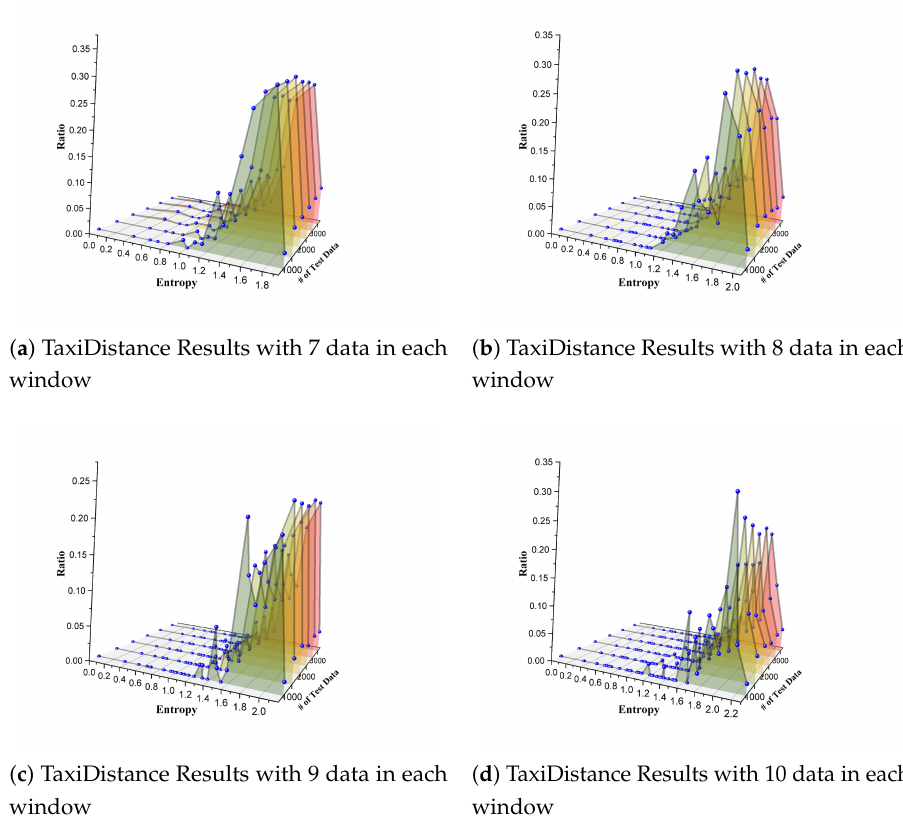
Figure 10. The distribution of